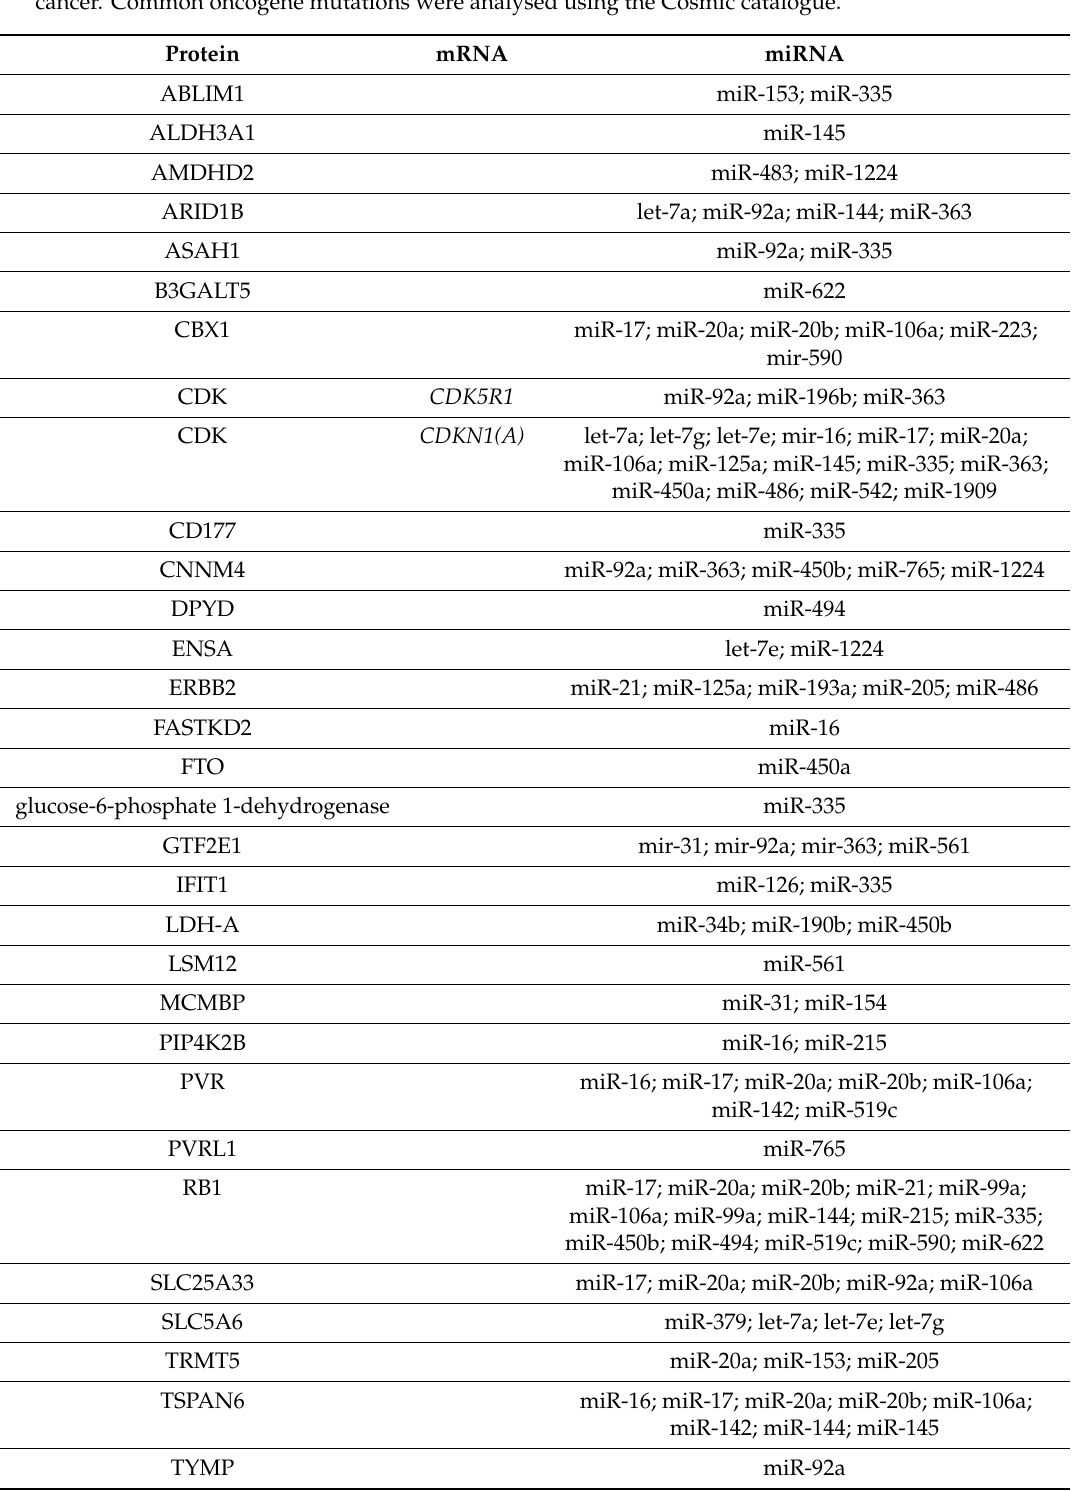
Table 2. Relationship between mRNA, miRNA and common oncogene mutations occurring in colorectal cancer. Common oncogene mutations were analysed using the Cosmic